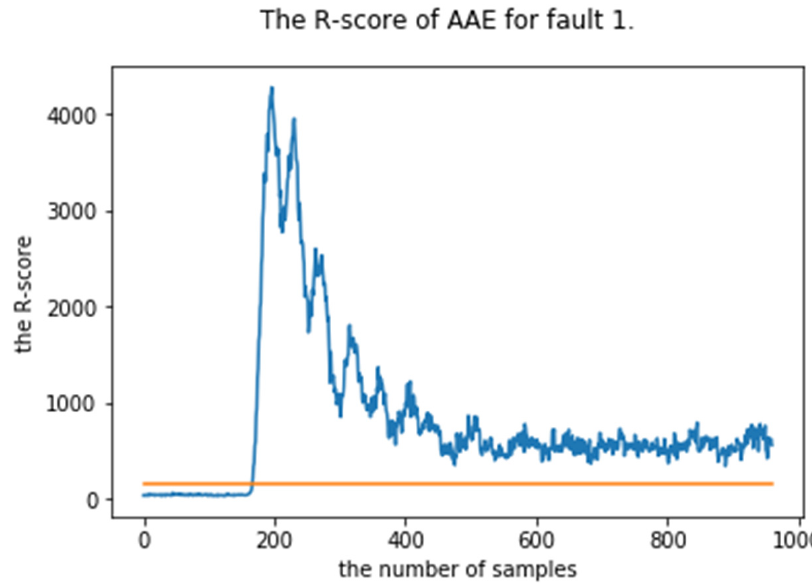
Figure 10. The R-score of the AAE for fault 1.